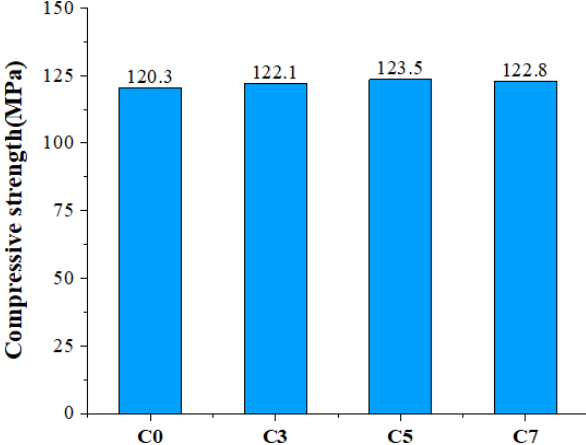
Figure 4: Compressive Strength of MWCNTs Reinforced UHPC